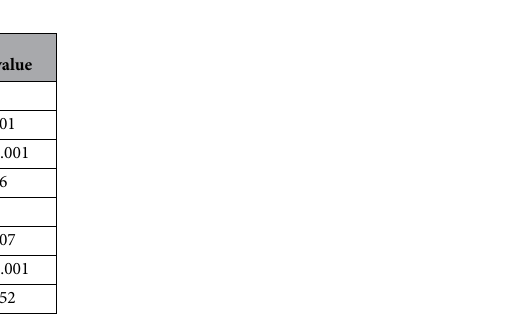
Table 2. Renal denervation procedure characteristics. * Standard anatomy, considered when single renal artery without any anatomical abnormalities on each site is present; LRA- left renal artery; RRA- right renal artery.